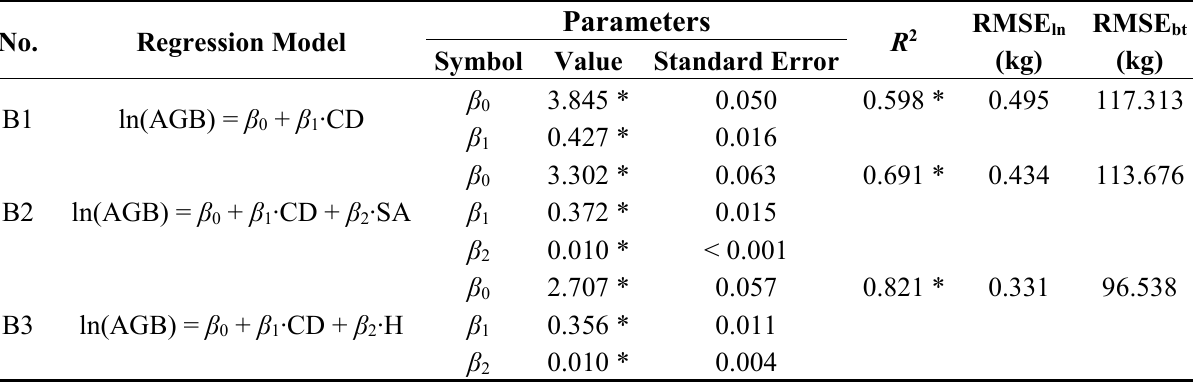
Table 5. Description and evaluation statistics of the three selected black pine aboveground biomass (AGB)